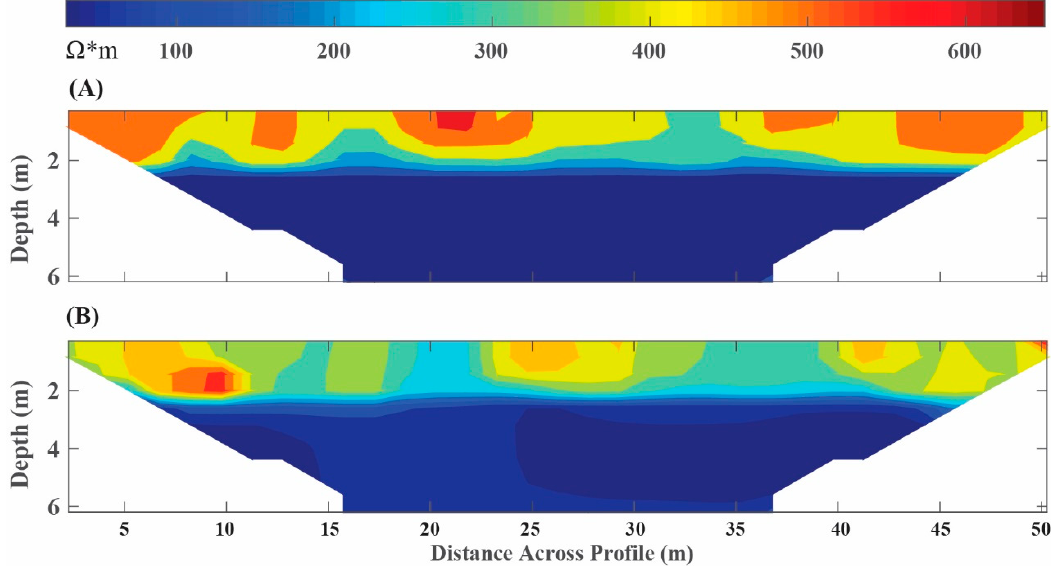
Figure 7. Inverted electrical resistivity profile before and after harvesting in Marian Meadow. The same profile and color bar of electrical resistivity values is represented in both panels. ( A ) Data collected on 7 September 2014. ( B ) Data collected on 9 September 2015. RMS inversion error: (A) 1.45% and (B) 1.43%.